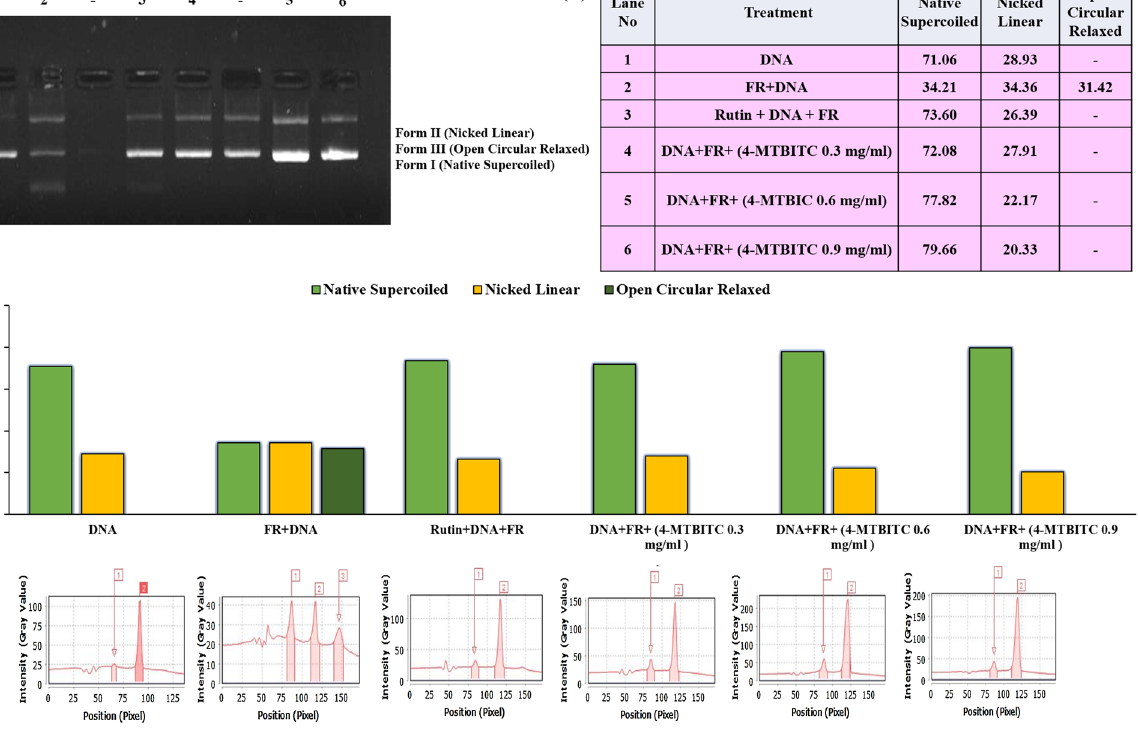
Figure 1. ( A ) Lane 1–6 represent protective effect of 4-MTBITC in pBR322 DNA nicking with Fenton’s reagent (FR). 1: native supercoiled DNA; 2: FR treated DNA; 3: FR treated DNA and rutin (100 μg/ml);